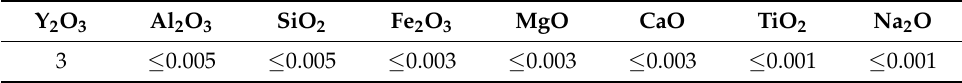
Figure 1. Scanning electron microscope (SEM) micrographs of powders: ( a ) 200 nm, ( b ) 100 nm. Table 1. Chemical composition of ZrO 2 powder